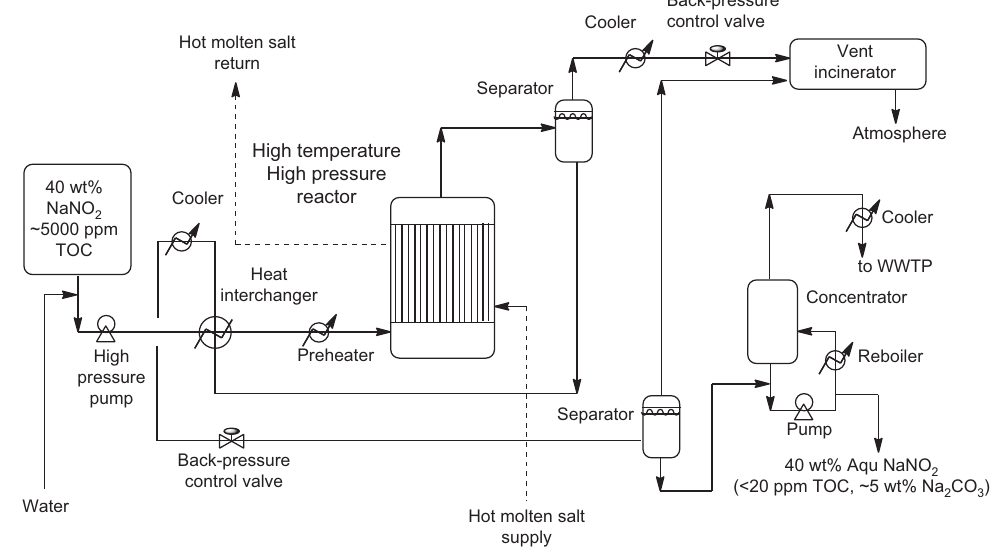
Figure 3 Process flow diagram of a high temperature and pressure destruction